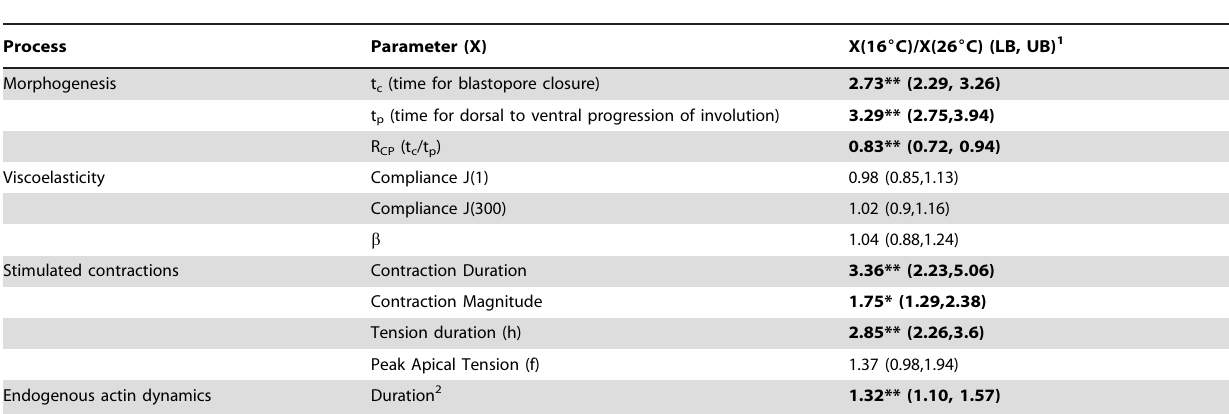
Table 3. Temperature dependence of mechanical and morphogenetic